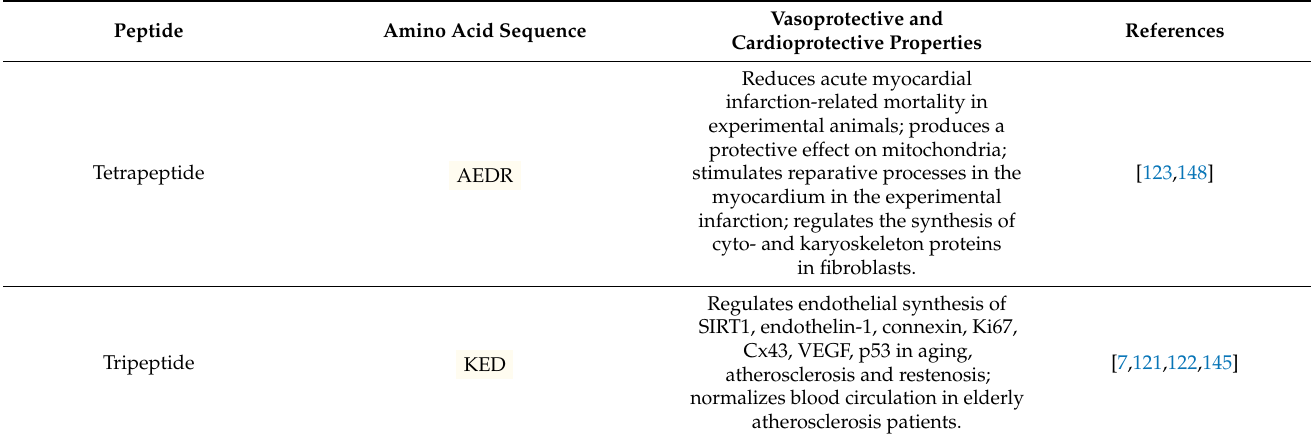
Table 2. Short peptides with vasoprotective and cardioprotective